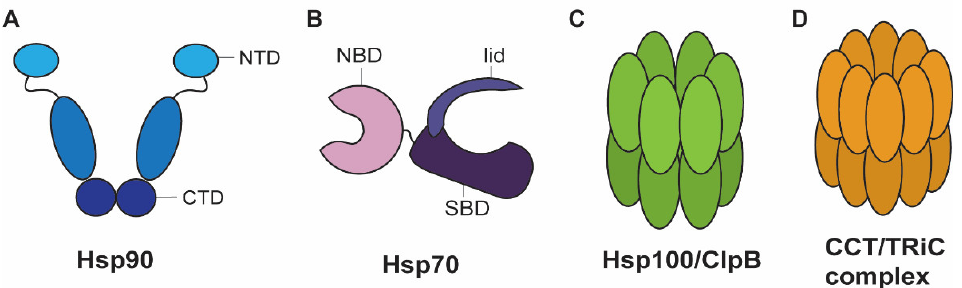
Figure 2. Schematic diagrams of the major classes of chaperones. ( A ) An Hsp90 dimer schematic indicating the ATP binding N-terminal domain (NTD) and the C-terminal domain (CTD) which is required for homodimerization. ( B ) An Hsp70 schematic indicating the nucleotide binding domain (NBD) and the substrate binding domain (SBD) including the lid of the SBD in an open conformation. ( C ) A schematic of an Hsp100/ClpB chaperone showing the stacked hexameric rings through which peptide strands are pulled to unfold them. ( D ) A schematic of a CCT/TRiC complex showing the stacked oligomeric rings which form a protected environment for protein folding in the lumen when ATP is bound and the chaperonin adopts a closed conformation.